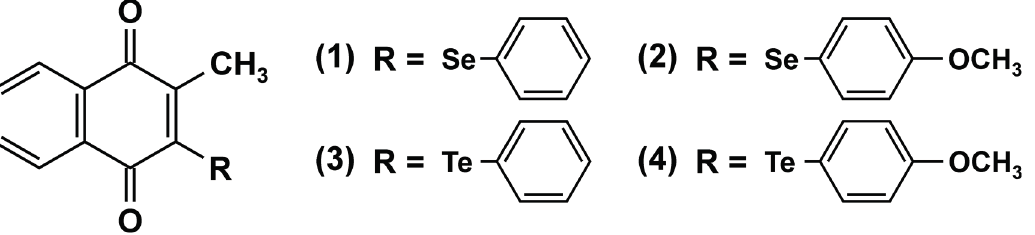
Figure 5. Selenium- and tellurium-containing menadione-derivatives developed by the group of Claus Jacob as multifunctional redox catalysts